Question: Describe this figure in one sentence.
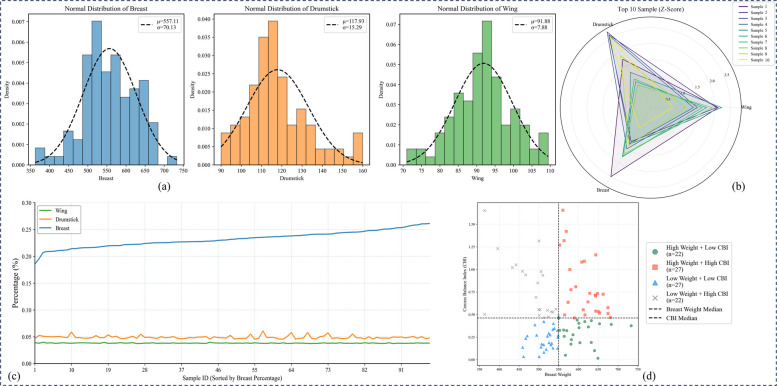
Answer: Multi-dimensional comprehensive assessment results of carcass traits of live poultry based on DR imaging. a Normal distribution map of predicted results for each region. b Radar chart of regional indices for the top 10 samples. c Comparison curve of muscle percentage calculated based on the predicted results of each region (samples sorted in ascending order according to breast muscle percentage). d Scatter plot of carcass balance index (CBI) versus breast weight (categorized by individual type)